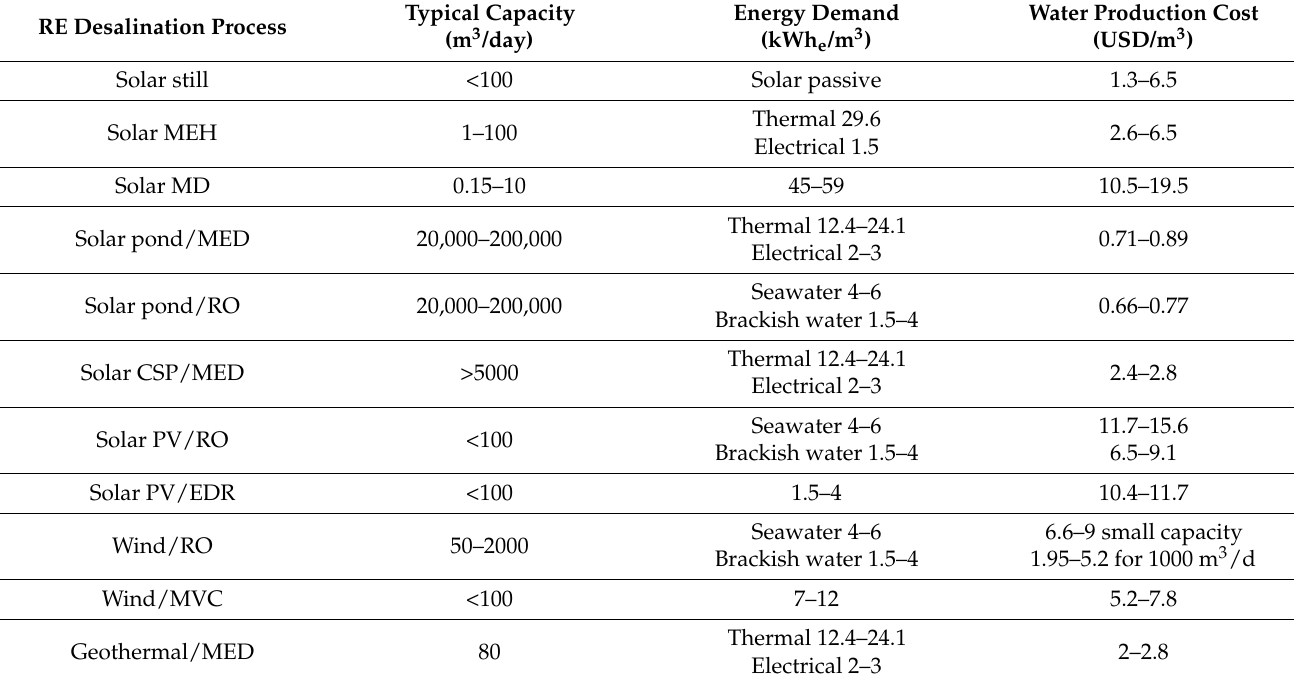
Table 4. Energy consumption and water production cost of renewable energy (RE) desalination [52] .